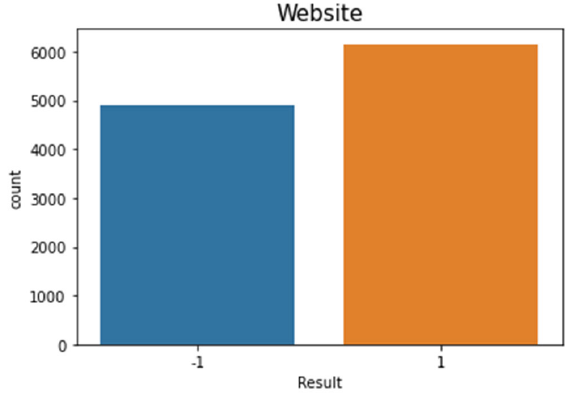
Fig. 3. Bar graph of the dataset used for website phishing. The dataset contains 6,157 legitimate and 4,898 phishing web- sites.